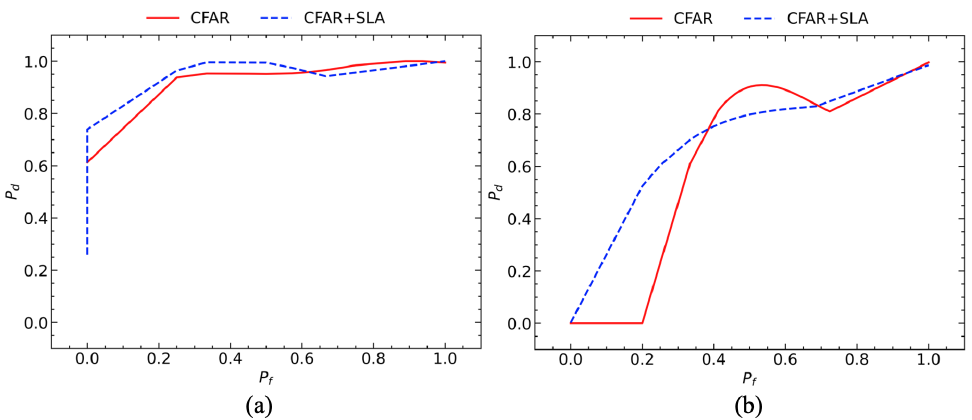
Figure 10. ROC evaluation of Cosmo-SkyMed (89 targets labeled) ( a ) and Sentinel-1 (290 targets labeled) ( b ) products in the Egadi Islands